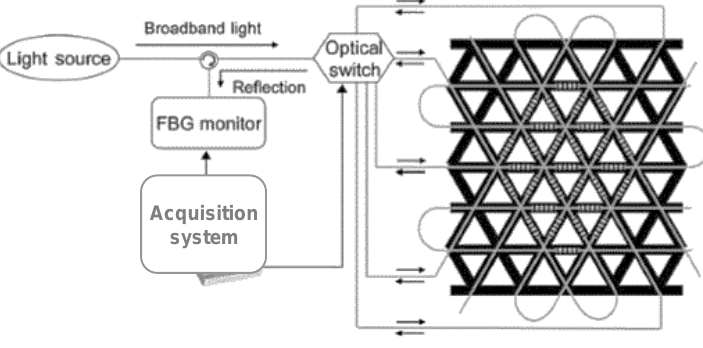
Figure 20. Advanced structural grid (AGS) with SHM system (adapted from